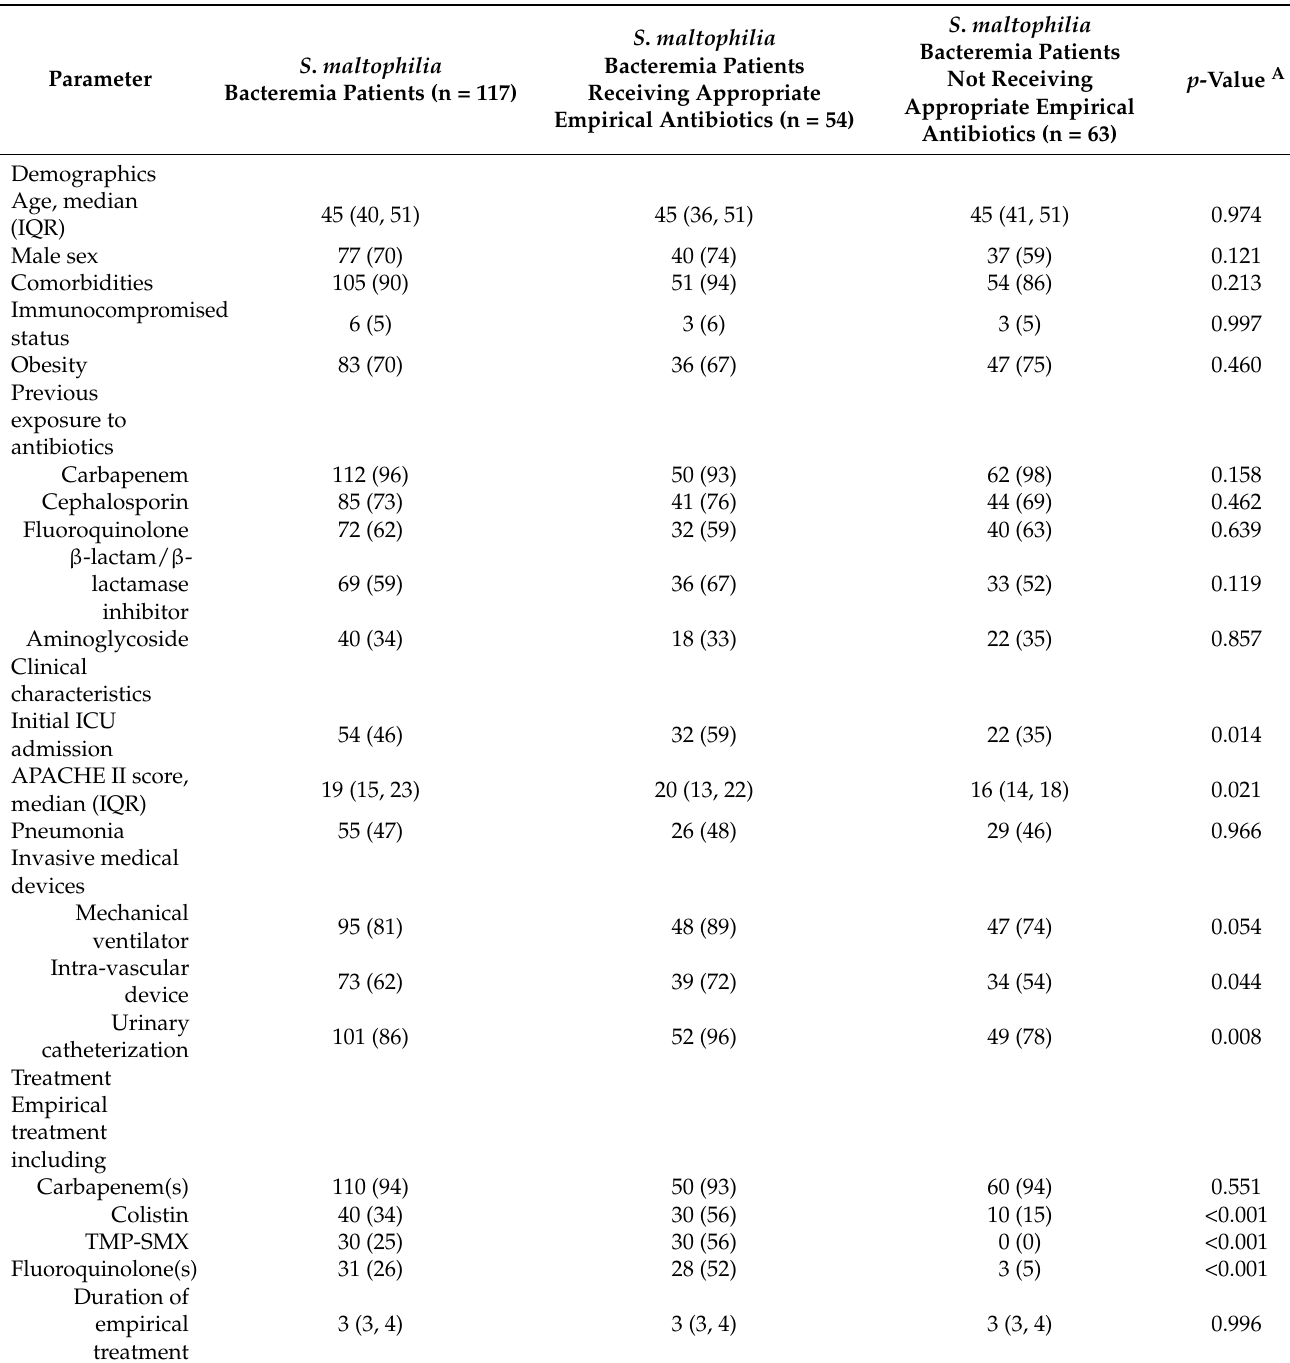
Table 1. Characteristics of S . maltophilia bacteremia patients and comparison of features between patients receiving and not receiving appropriate empirical